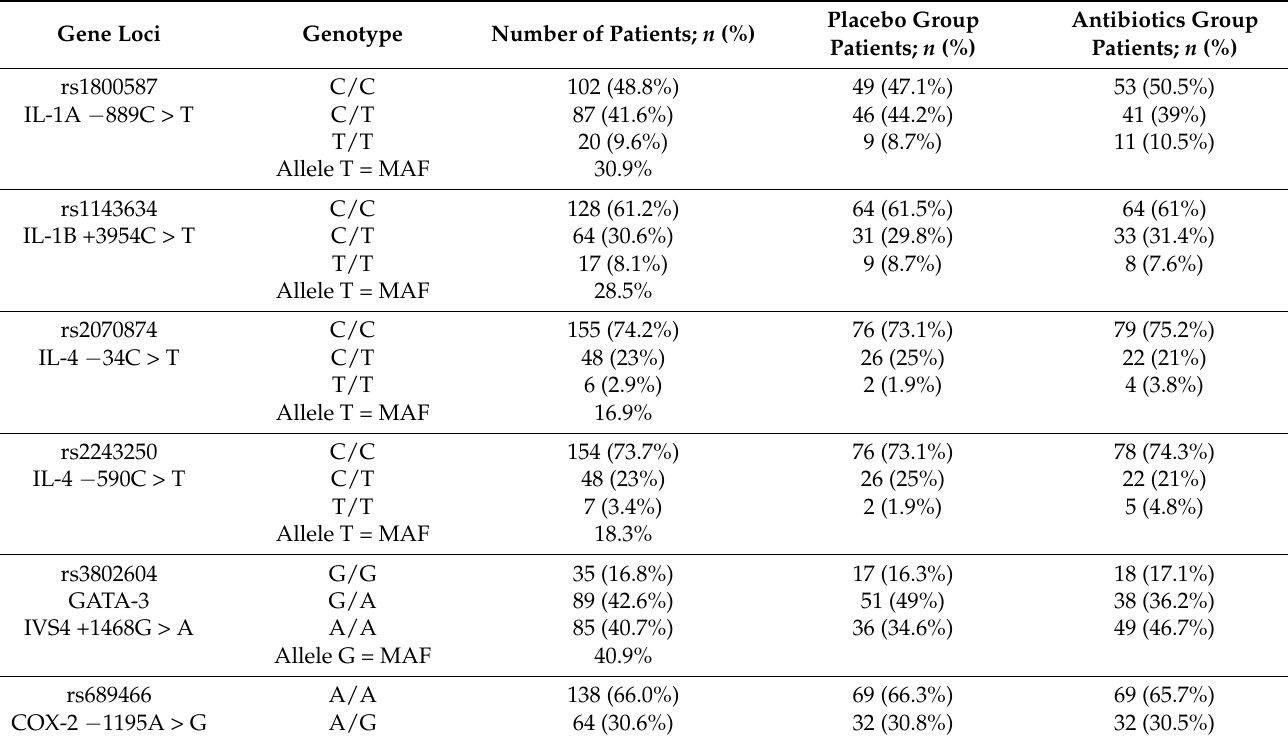
Table 2. Genotype